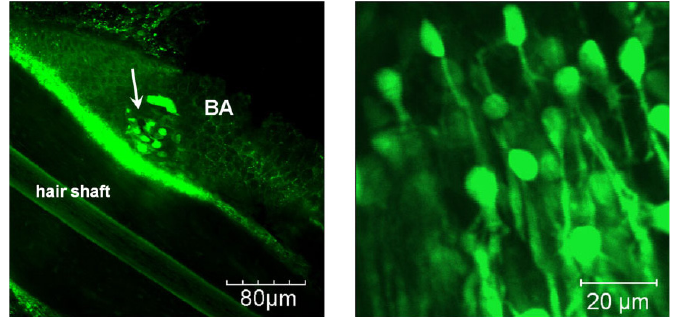
Fig. 3. Typical nestin-GFP expressing stem cells within the hair follicle bulge (white arrow). The cells have an oval-shaped body with a typical size of 7 mm and dendritic-like arms. Images were obtained from fresh isolated hair follicles by confocal 3D optical slicing. Reproduced with permission from Ref.